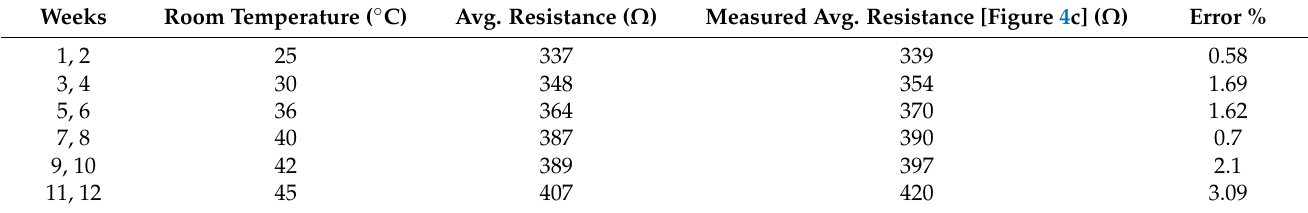
Table 4. Fabricated RTD values at different room temperatures, recorded over three months.